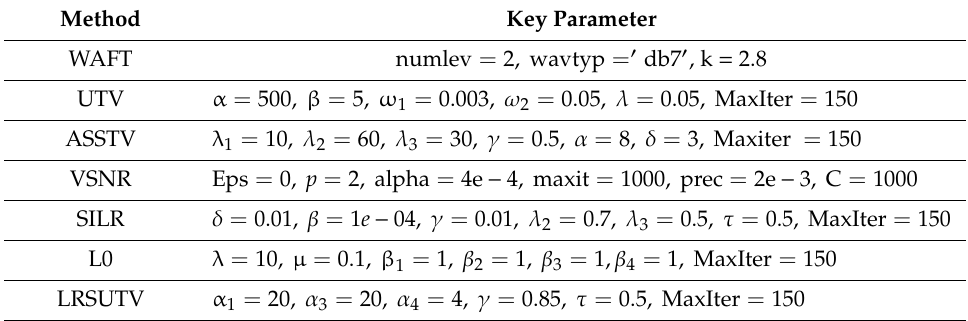
Table 5. Parameter settings of various methods being compared.